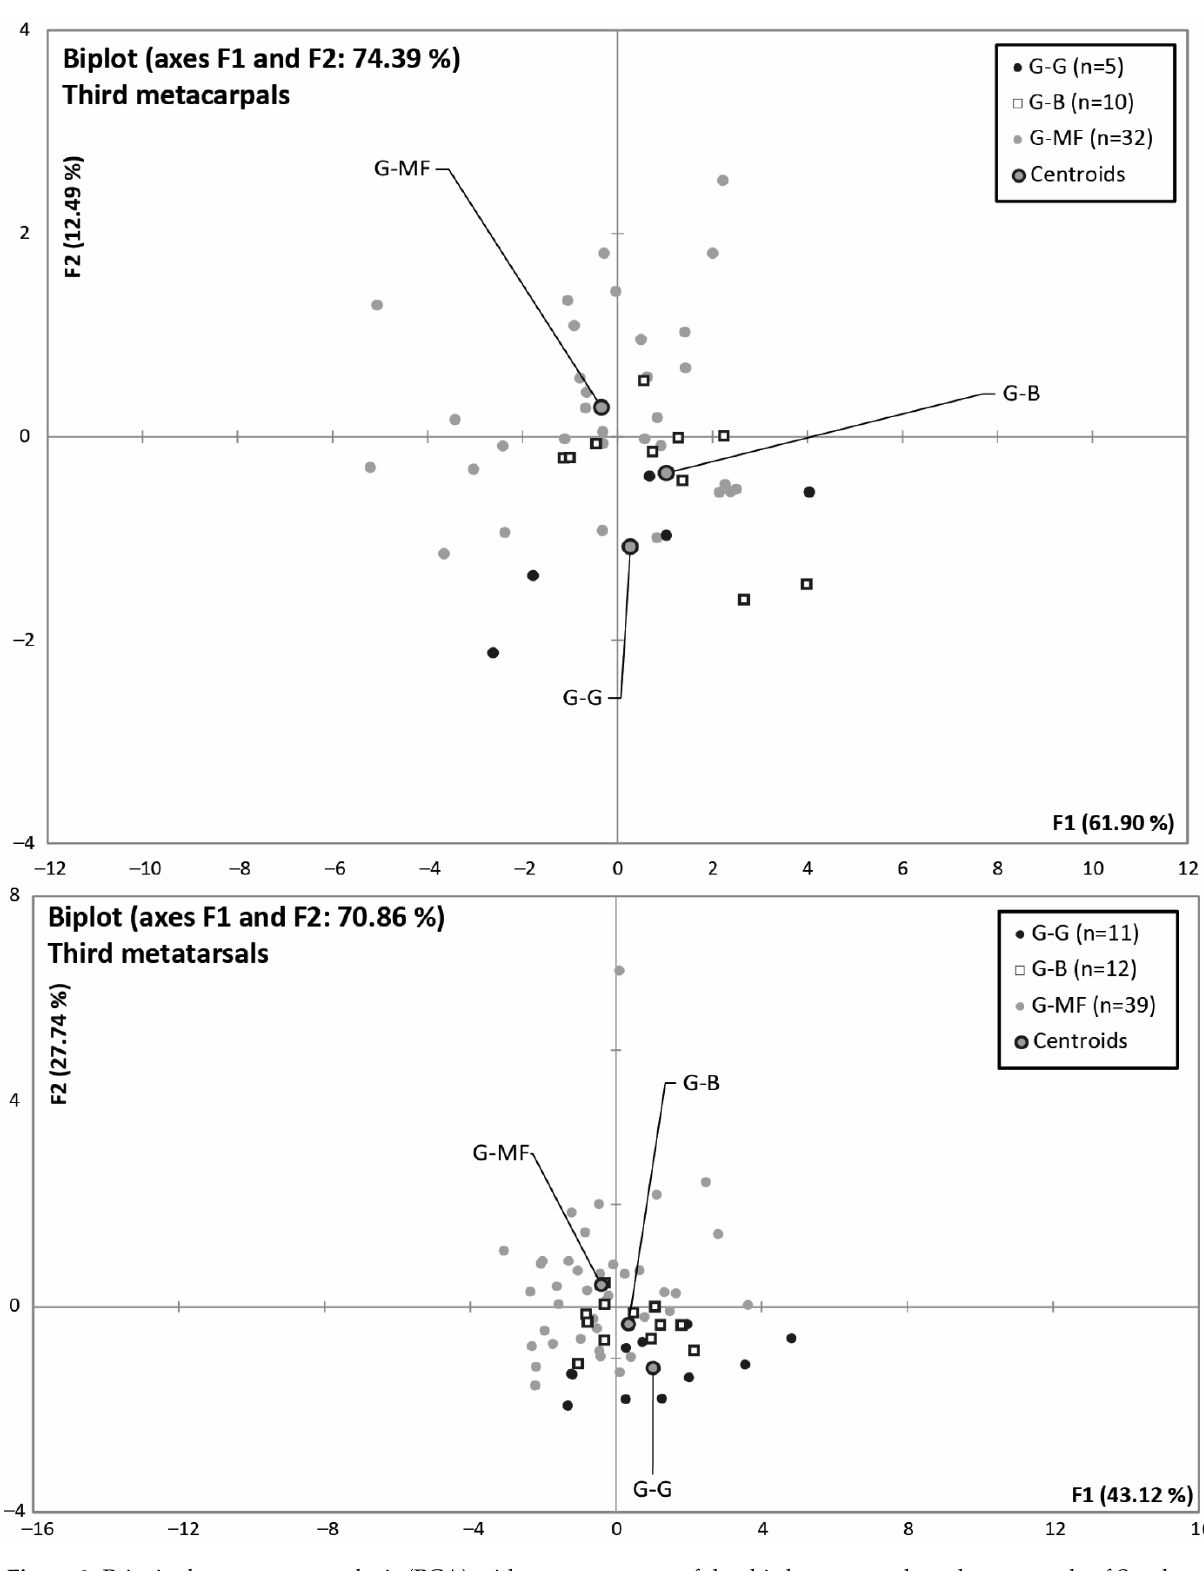
Figure 9. Principal component analysis (PCA) with measurements of the third metacarpals and metatarsals of Southern Middle and Late Pleistocene caballoid horses with regards to the dietary categories displayed by meso- and microwear analysis. G-G: grazer all year long; G-MF: generally, grazer, mixed-feeder at the time of death; G-B: generally, grazer, browser at the time of death. The large dots correspond to the centroid of each dietary category. For the correlation circles, see Figure 5 for metacarpals and 6 for metatarsals.